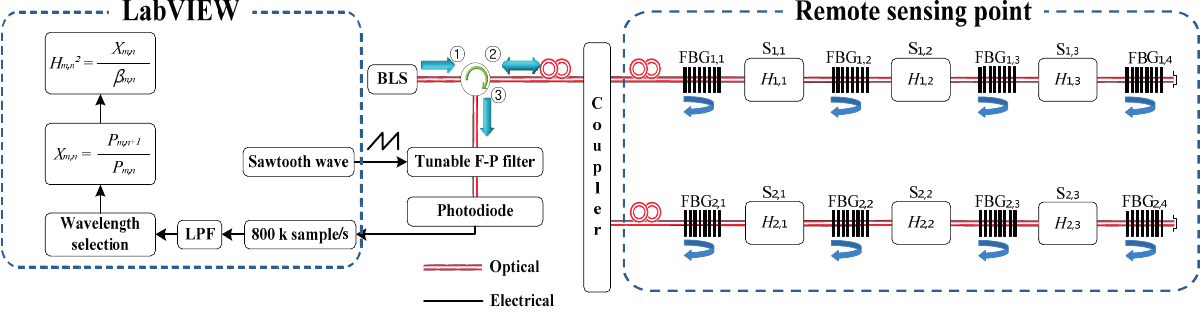
Figure 1. Experimental setup for the proposed self-referencing intensity-based fiber optic